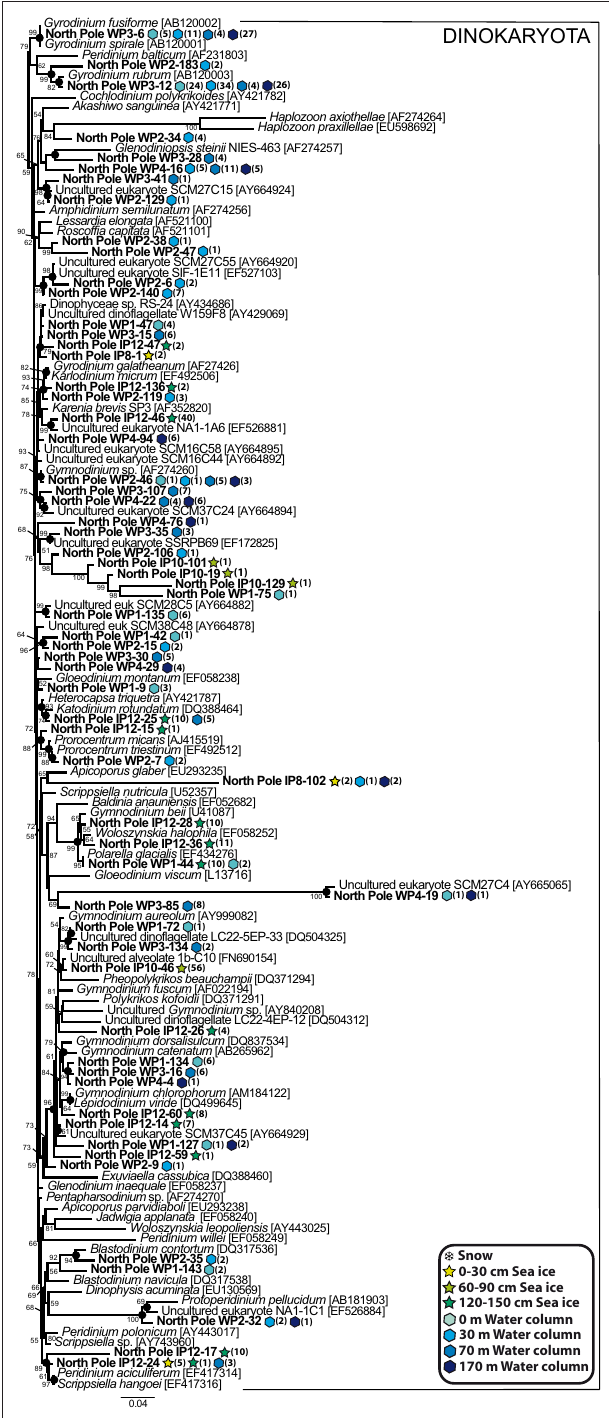
High Arctic snow samples showing the significant role played by wind in the aerial transport of microorganisms in this environment (Harding et al., 2011). In contrast with snow, the diversity of